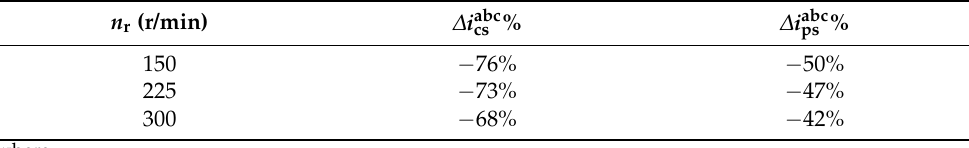
Figure 12. The comparison data of the simulation experiment of the MTPA-(SFV-FLC) control algorithm with and without parameter deviation at different speeds. Table 4. When there is a deviation in the parameters, the current comparison of the two control methods of MTPA-(SFV-FLC) and (SFV-FLC) at different speeds.